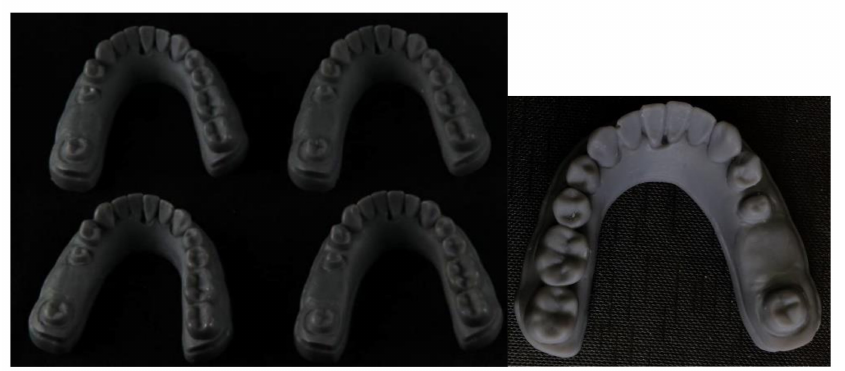
Figure 3. Printed working